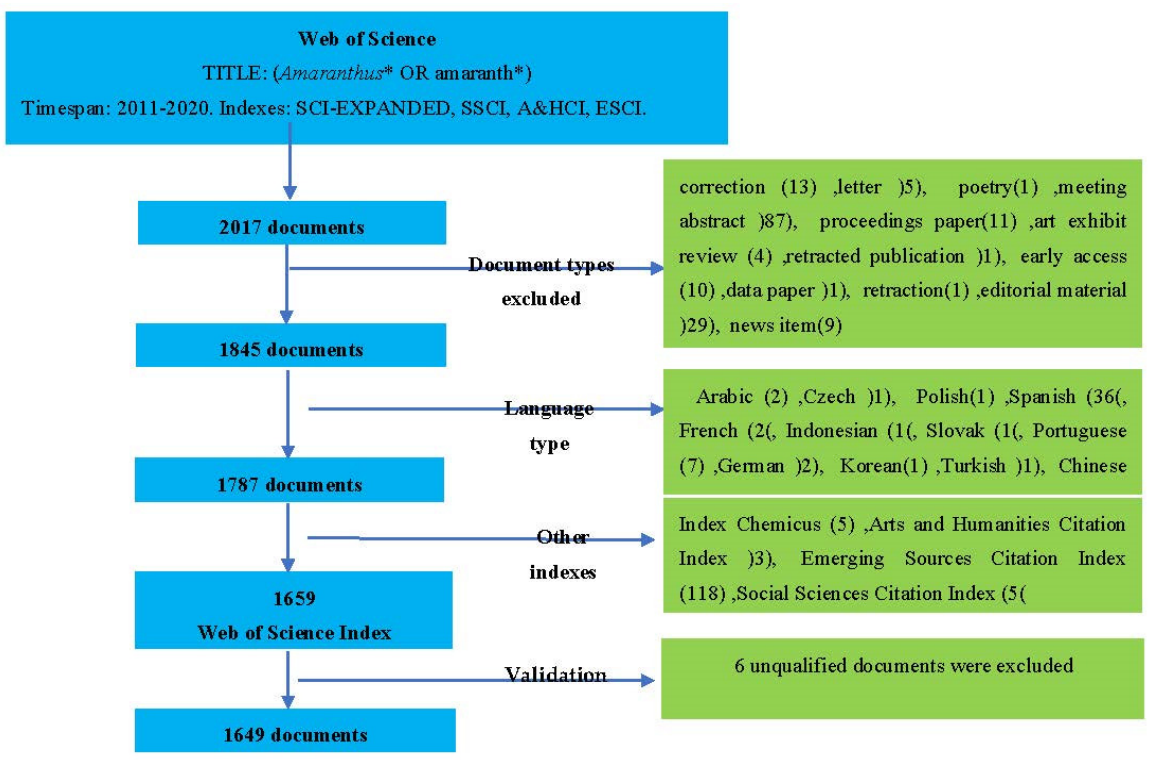
Figure 1. PRISMA flowchart of data collection from Web of Science Core Collection (WoSCC) on Amaranthus research from 2011 to 2020.